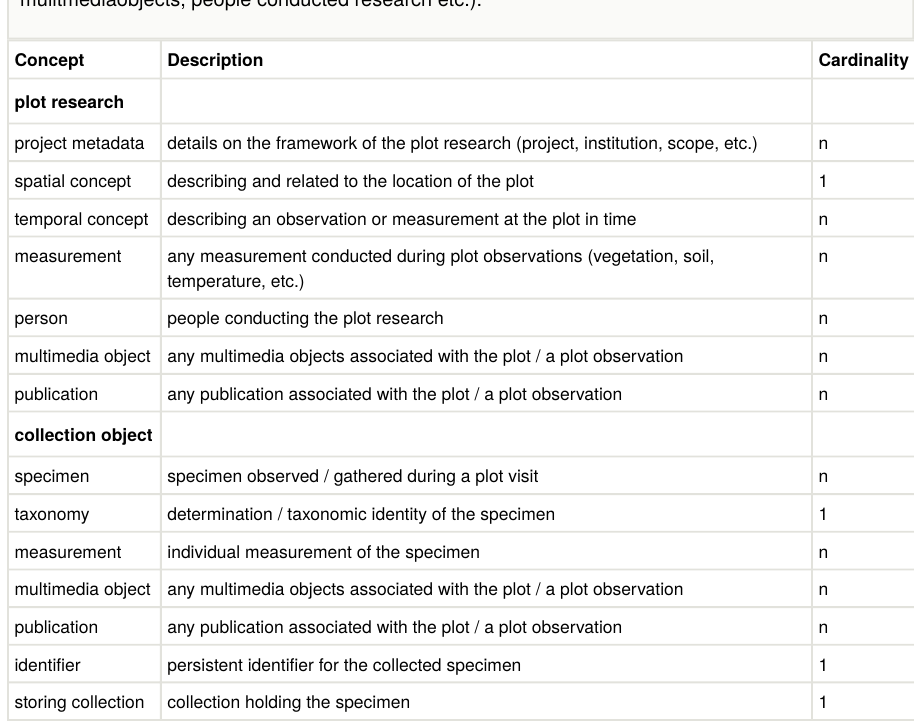
Table 1. Concepts of a fi rst version of an application schema for plot-based data in combination with collection objects. Given are concepts discussed during the workshop and which should be incorporated in an application schema (compare Fig. 1). In addition to a short description we assigned the cardinality to each concept. Various concepts are of importance for the plot research as well as for the description of the collection object (e.g. measurements, associated mulitmediaobjects, people conducted research